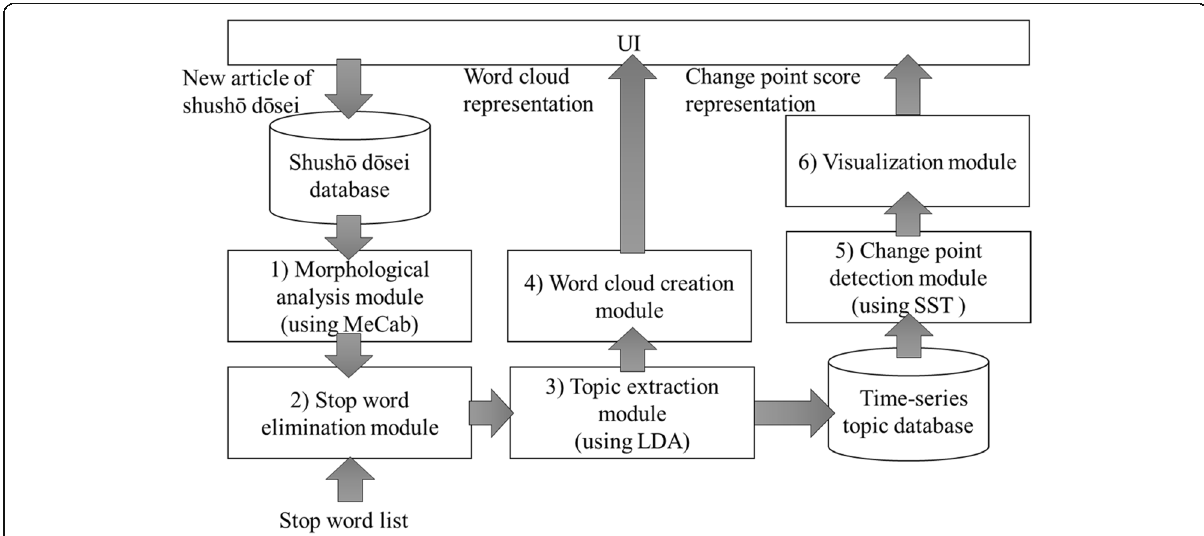
Fig. 4 Overview of the experimental